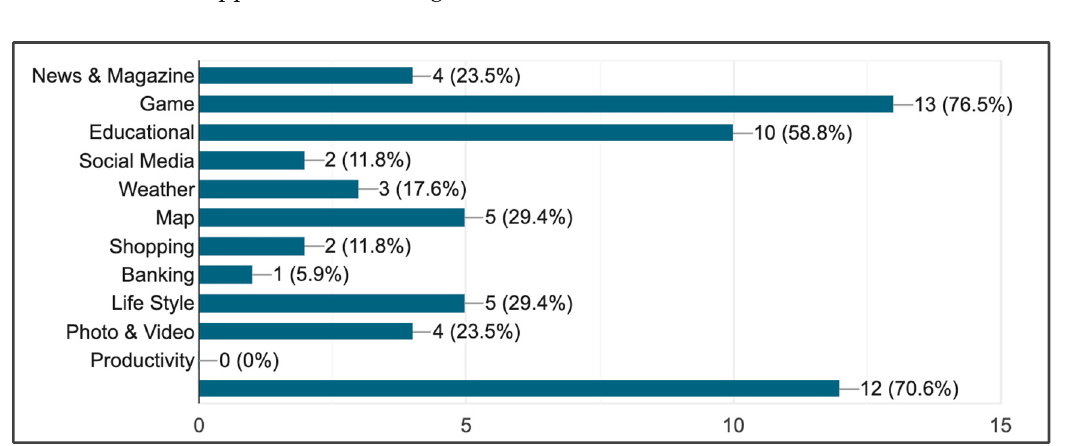
Figure 17. Students’ preference to the development mobile app categories.